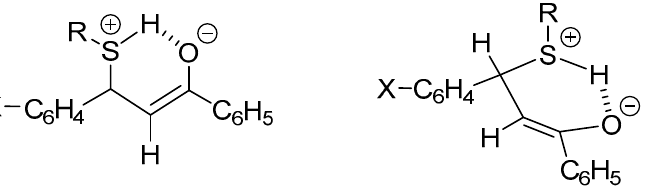
Figure 9. Possible enolate intermediate of the addition of protonated thiols onto chalcones.